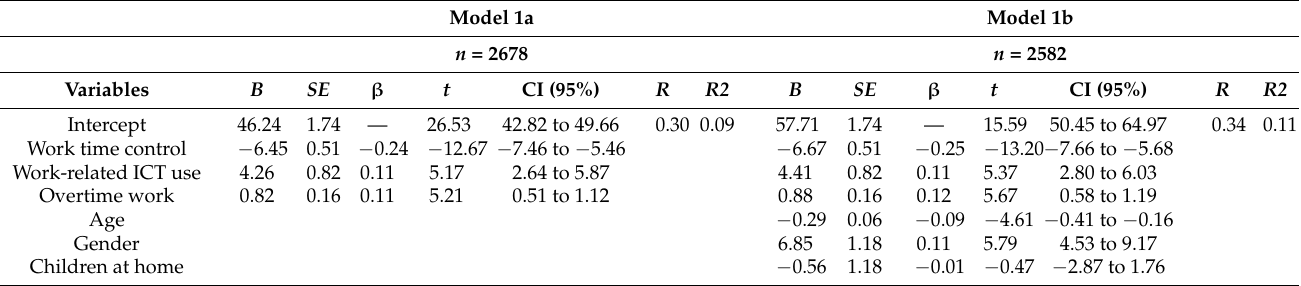
Table 3. Associations from the multiple linear regression analysis of relations between the deter- minants work time control (WTC), work-related ICT use, and overtime work and the dependent variable need for recovery (NFR), without (Model 1a) and with adjustment (Model 1b) for age, gender and children at home. Unstandardized and standardized coefficients are reported.